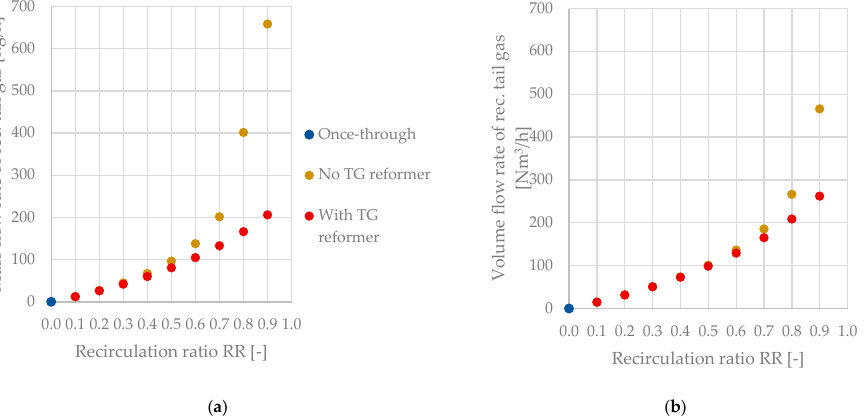
Figure 9. Recirculated tail gas as a function of the recirculation ratio RR and the process configuration—( a ) mass flow rate, ( b ) volume flow rate.